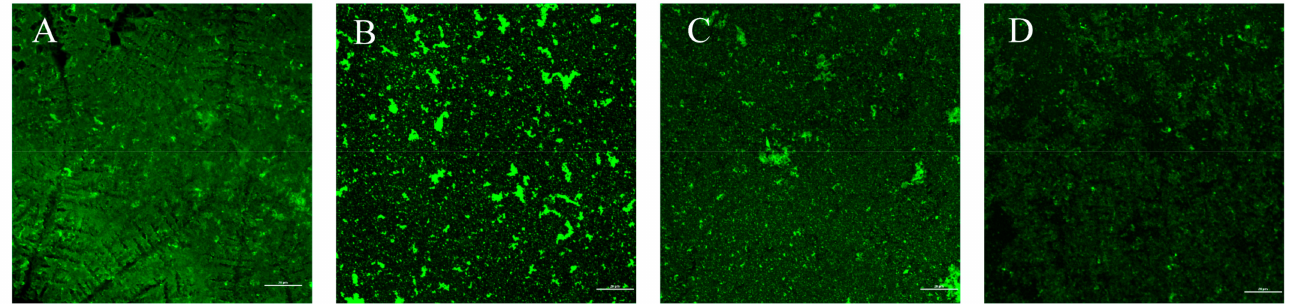
Figure 9. CLSM of the H. pylori 3192 biofilm EPS under different treatments. ( A ) Control, ( B ) 1/2 × MIC of LN12 CFS treatment, ( C ) 1 × FIC of AMX and CLR treatment, ( D ) 1/2 × MIC of LN12 CFS in combination with 1 × FIC of AMX and CLR treatment. The scale bar is 20 µ m. AMX: Amoxicillin, CLR: